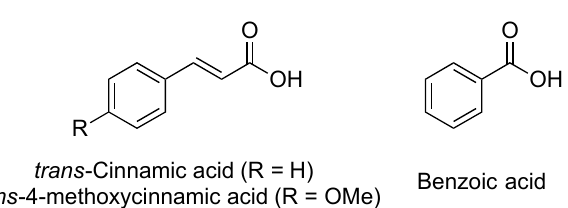
Figure 13. Structures of trans -cinnamic acid (TCA), trans -4-methoxycinnamic acid (TMCA), and benzoic